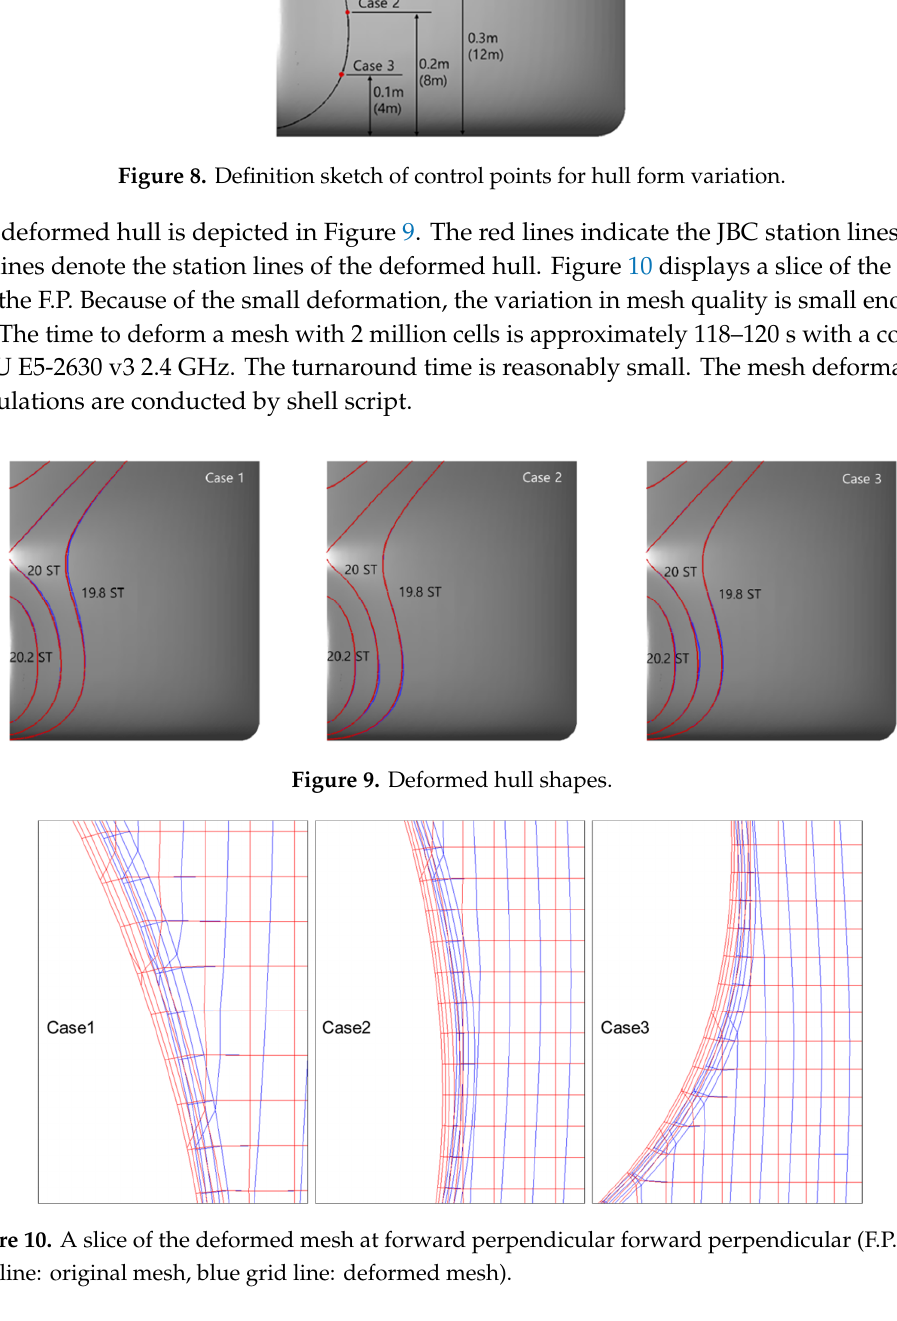
Figure 8. Definition sketch of control points for hull form variation.